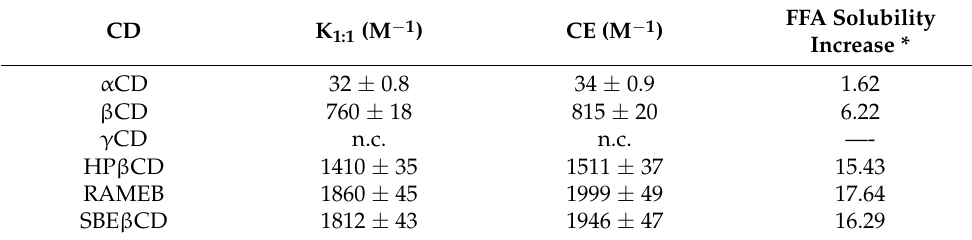
Table 1. Stability constants (K1:1) and complexation efficiency (CE) of the complexes of flufenamic acid (FFA) with different